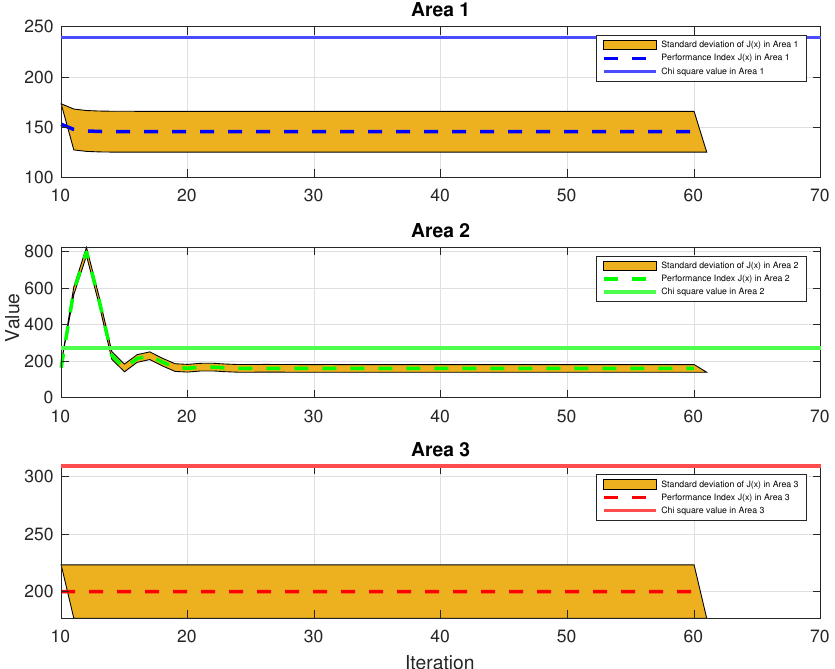
Figure 10. Per area mean of J(x) on the IEEE-118 bus system 3 regions with standard deviation.